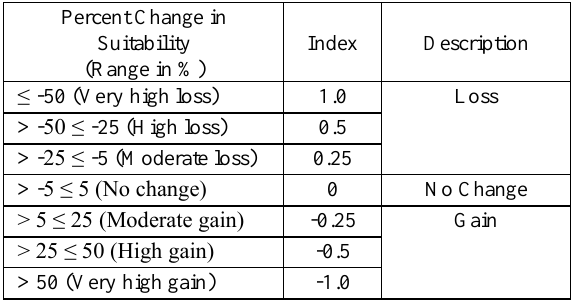
Table 2. Sensitivity index based on percent change in crop suitability from baseline to future condition.